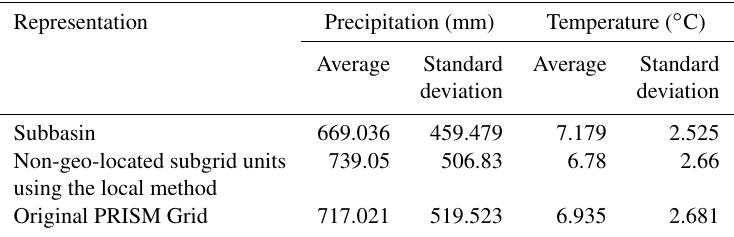
Table 2. Comparing the SUs generated using 3% area threshold from the local method and subbasin representations against the original PRISM grid representation using statistical summary of mean annual precipitation and surface temperature calculated over the study domain.